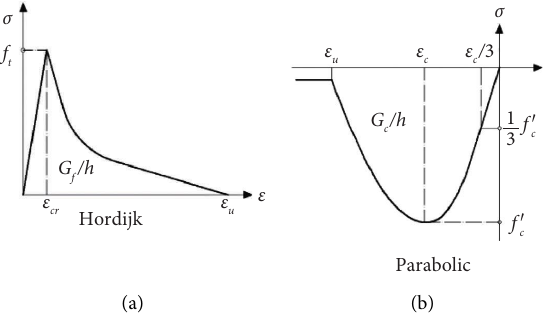
Figure 7: Constitutive model for concrete. (a) Predefned tensile stress-strain curve. (b) Predefned compressive stress-strain